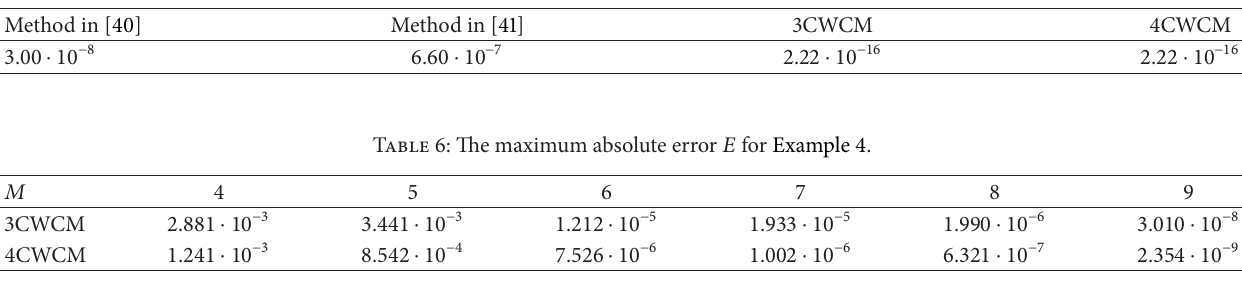
Table 5: The best errors for Example 3.